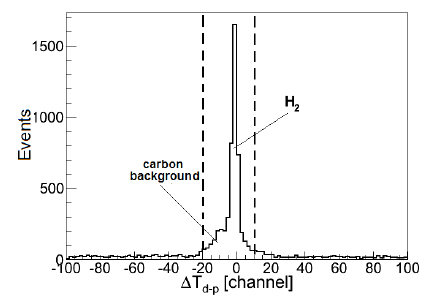
Figure 2. Correlation of the deuteron and pro- ton energy losses at 500 MeV / n for θ c . m . = 75 ◦ . The dashed line represents the graphical criterion for separation of dp -elastic scattering events